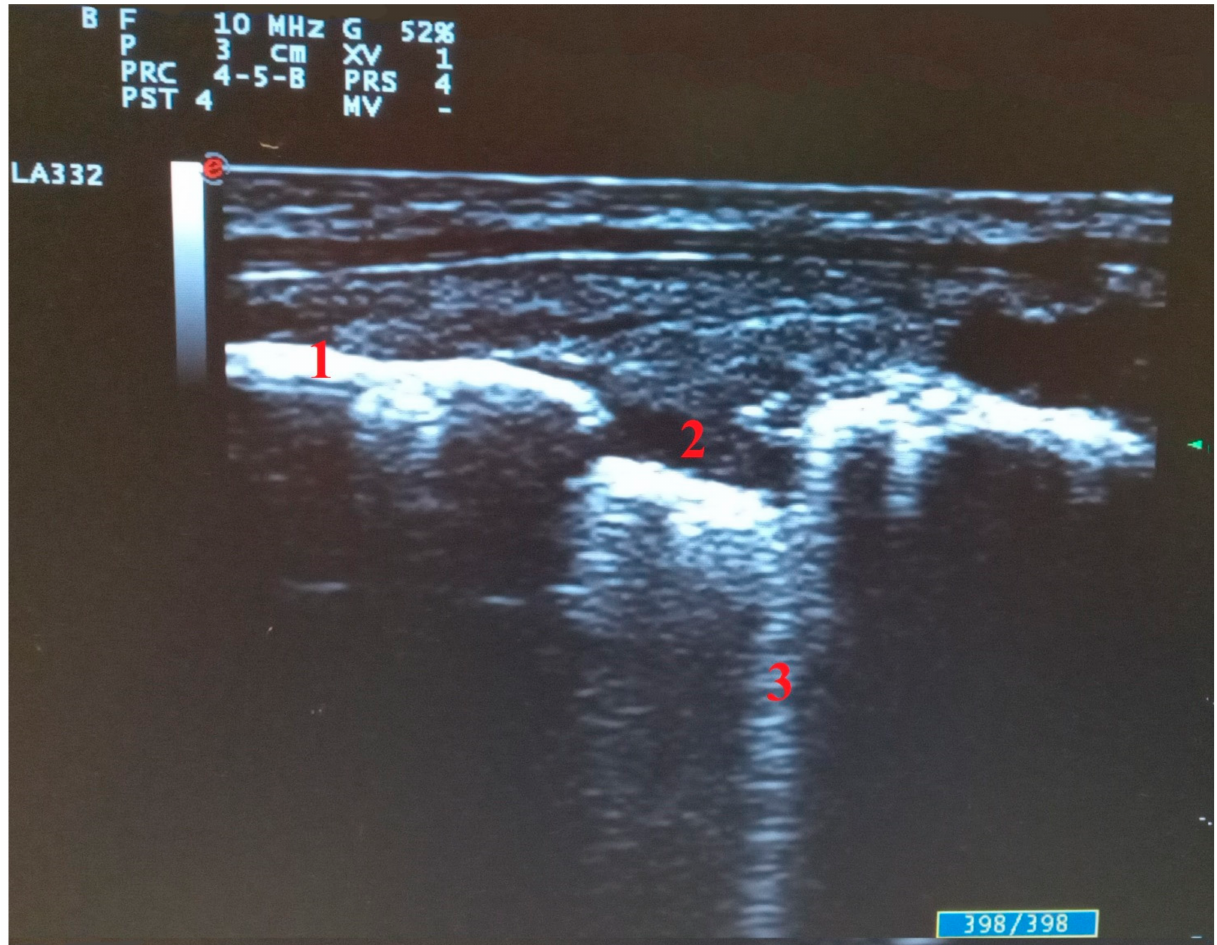
Figure 4. Abnormalities of pleural line in transversal scan: (1) pleural line, (2) pleural line interruption with subpleural consolidation, (3) single B line arising from subpleural